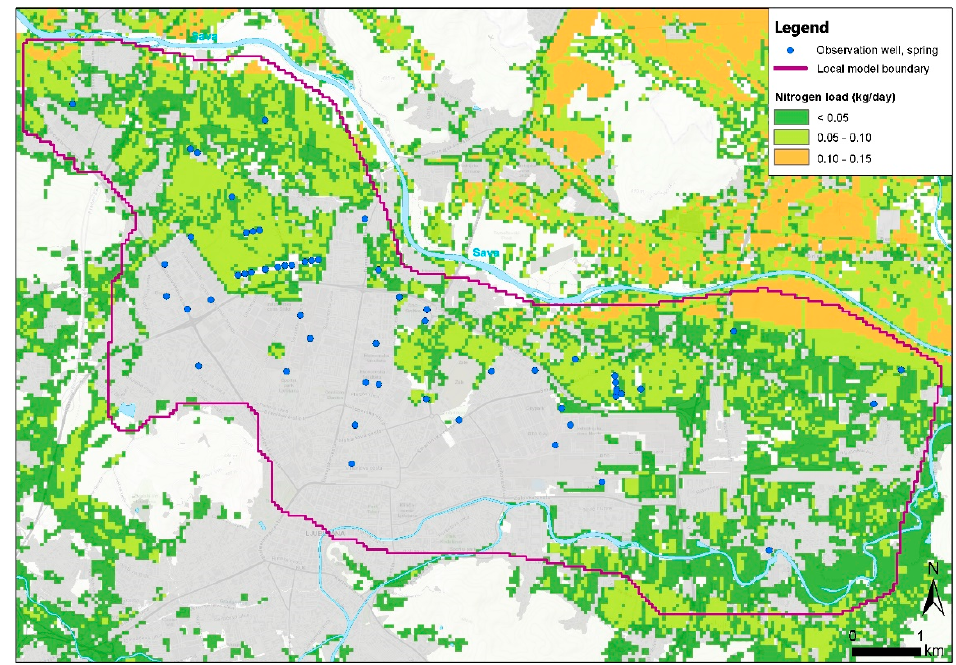
Figure 7. The spatial distribution of the estimated nitrogen load from agriculture (in kg/day per 50 m grid